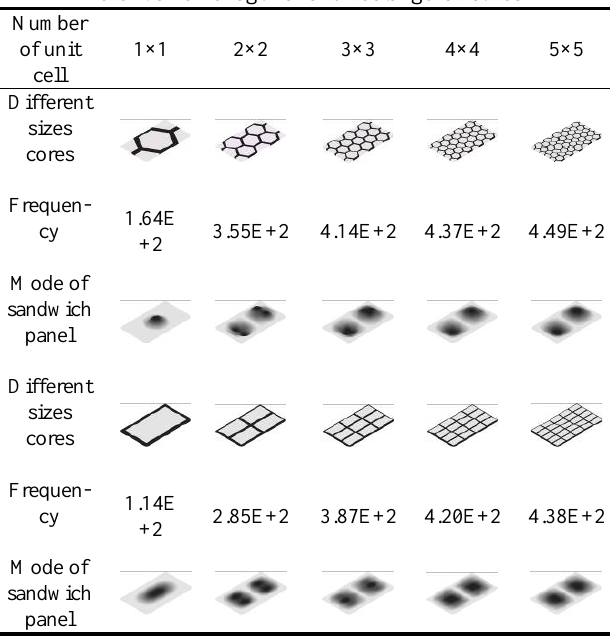
Table 9. The second order vibration response with the dif-